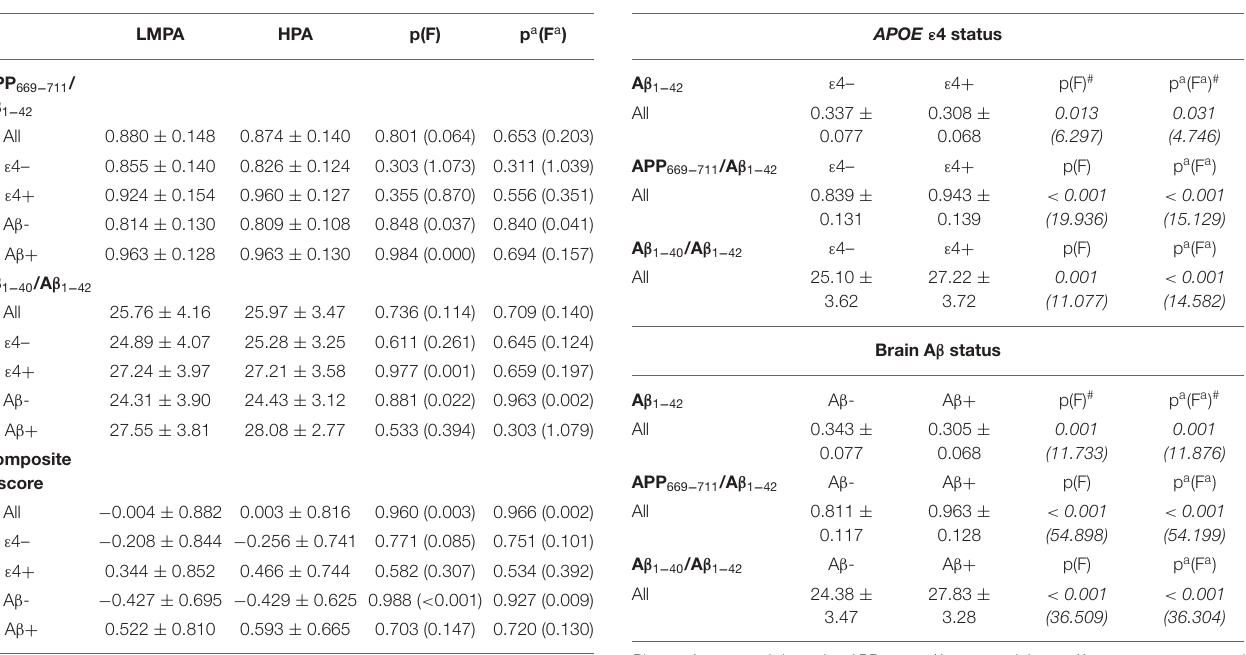
TABLE 4 | Comparison of the effect of APOE ε 4 status and brain A β status on plasma A β 1 − 42 levels and blood biomarker ratios.